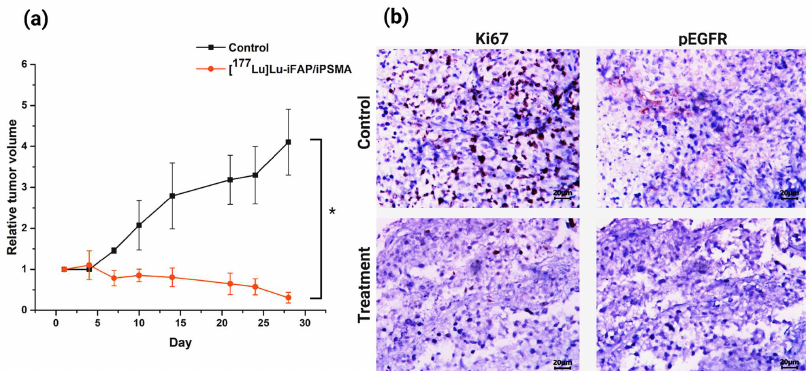
Figure 3. ( a ) Effect of [ 177 Lu]Lu−iFAP/iPSMA treatment on HCT116 colorectal cancer xenograft tumors in nu/nu mice. Note a significant decrease in the relative tumor volume in mice treated with the nanoparticles compared to the control group. ( b ) Representative light micrographs (magnification of 400×) of immunohistochemical staining (dark brown color) for cell proliferation markers Ki67 and pEGFR in colorectal cancer xenograft tumors. Note the significant effect of [ 177 Lu]Lu−iFAP/iPSMA on the decrease of tumor cell proliferation with regard to the control group. *Statistically significant difference ( p < 0.05). Histological analysis (H&E staining) of brain, lung, kidney, and ovarian tissues from [ 177 Lu]Lu−iFAP/iPSMA-treated and control mice evidenced no tissue toxicity (Figure 4). Nanomaterials 2022 , 12 , x FOR PEER REVIEW As previously reported [27], [ 177 Lu]Lu-iFAP and [ 177 Lu]Lu-iPSMA biokinetic profiles showed that the liver is the organ with the highest nanoparticle accumulation, followed